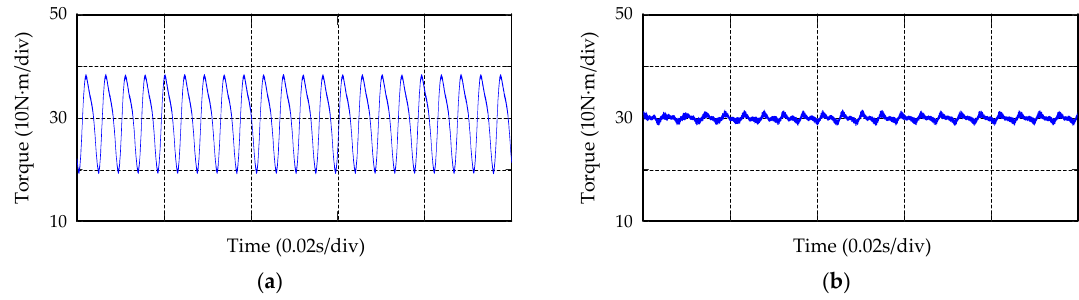
Figure 16. Torque waveform when the speed of five-phase PMSM is 600 r/min: ( a ) Torque waveform of removing faulty phase after a short-circuit; ( b ) Torque waveform after adding RC.